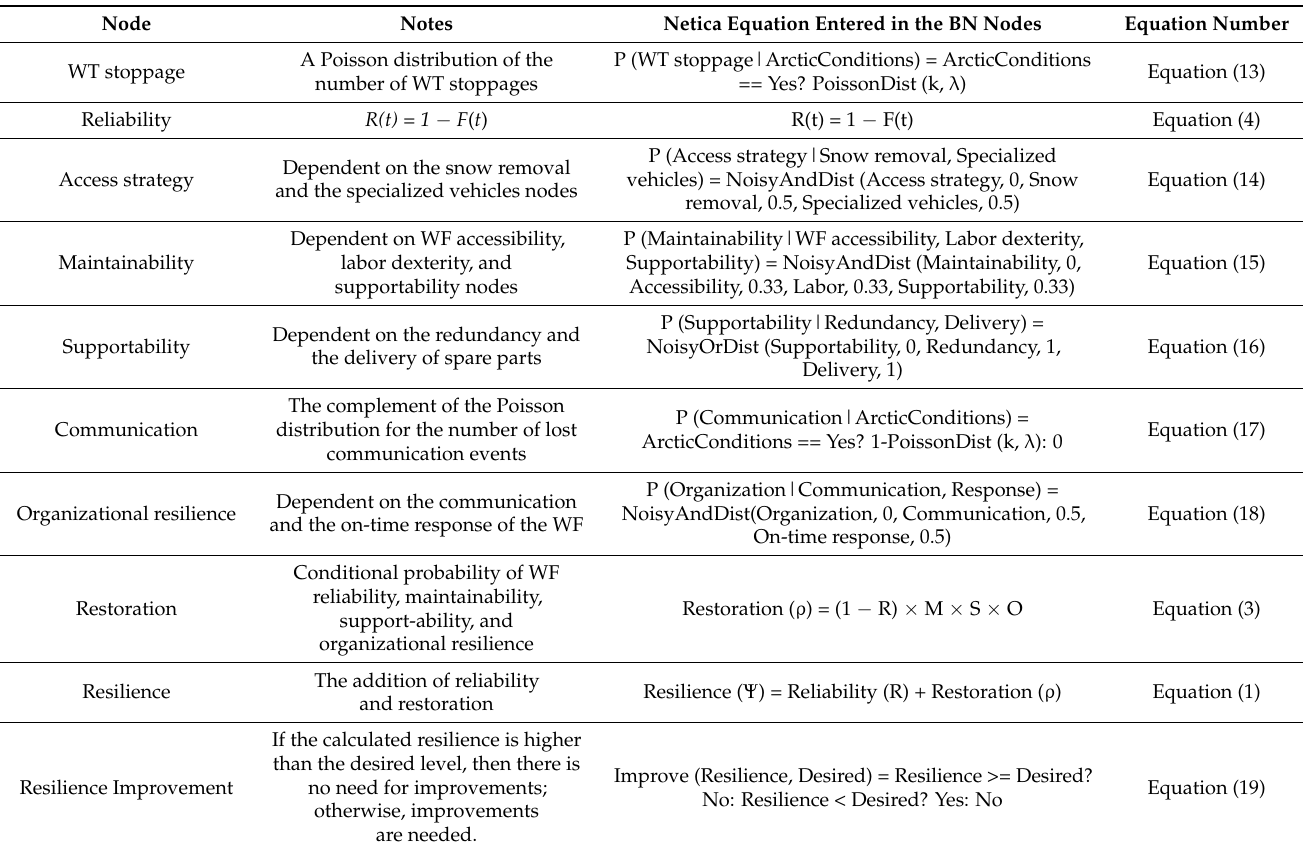
Table 1. Summary of the modeled equations used by Netica in the designed